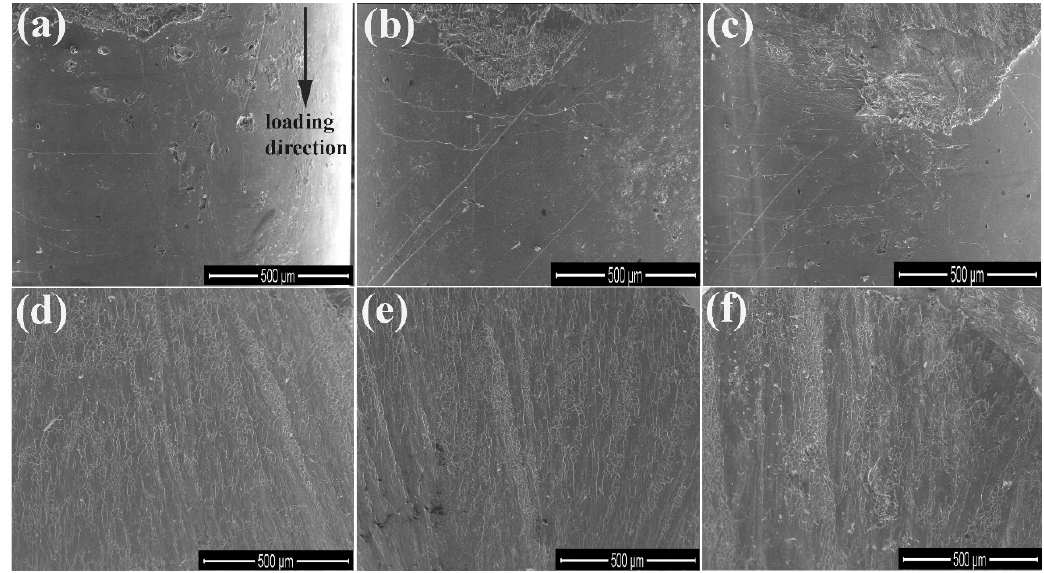
Figure 12. Typical SEM images of side surfaces ( a – c ) and fracture surfaces ( d – f ): ( a , d ) Zr 51 Al 14.2 Ni 15.9 Cu 18.9 , Zr 51.5 Al 13.6 Ni 14.9 Cu 20 , Zr 52 Al 12.9 Ni 13.8 Cu 21.3 , and Zr 54 Al 10.2 Ni 9.4 Cu 26.4 BMGs; ( b , e ) Zr 53 Al 11.6 Ni 11.7 Cu 23.7 and Zr 54.5 Al 9.6 Ni 8.4 Cu 27.5 BMGs; and ( c , f ) Zr 52.5 Al 12.2 Ni 12.6 Cu 22.7 and Zr 55 Al 8.9 Ni 7.3 Cu 28.8 BMGs.